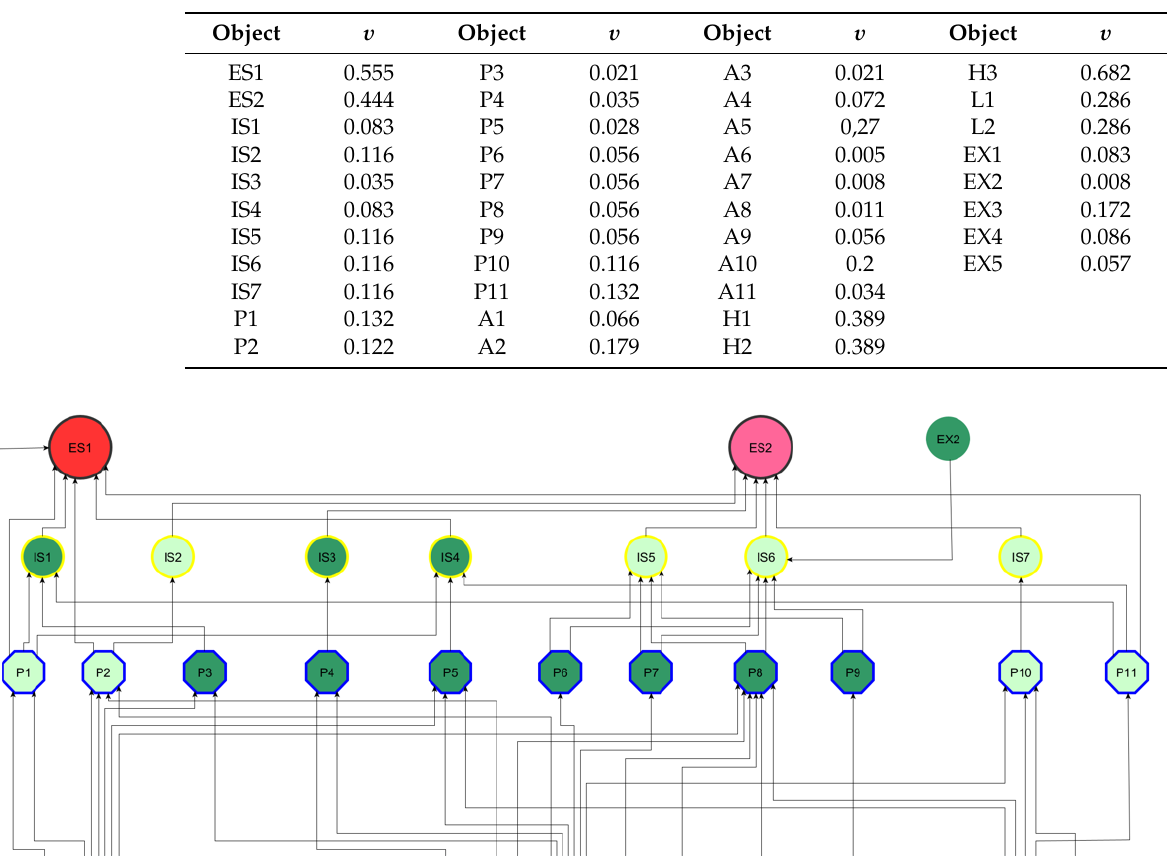
Table 4. Business criticality of objects.